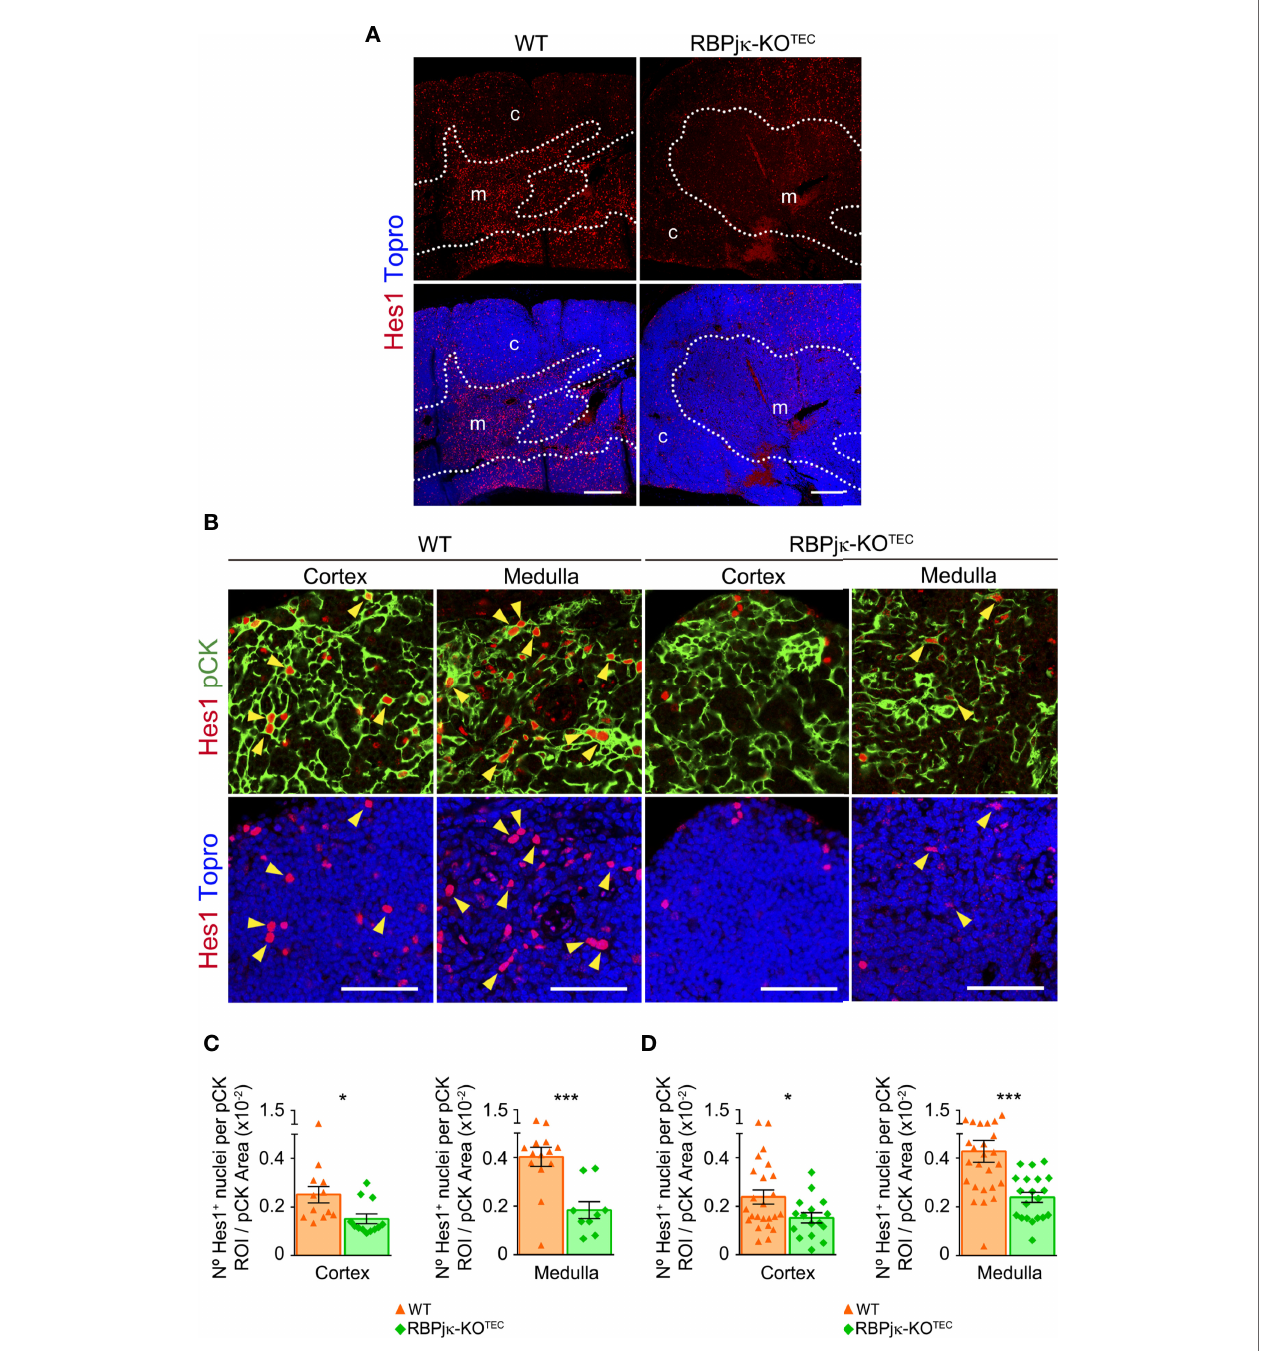
FIGURE 4 | Abrogation of canonical Notch signaling in postnatal TECs of RBPj k – KO TEC mice. (A) General view of Hes1 expression (red) in postnatal thymi (5- months) of mutant RBPj k – KO TEC and WT Foxn1 +/+ x RBPjk fl / fl littermate mice. Topro3 shows nuclear staining (blue). Scale bar: 200 m m. c, cortex; m, medulla. Dotted line, corticomedullary junction. (B) Immunohistochemistry of Hes1 (red), and pCK (green) with nuclei in blue (Topro3) in the cortex and medulla of postnatal thymi (5- months) from WT and RBPj k – KO TEC mice. Arrowheads indicate Hes1 nuclear expression. Scale bars: 50 m m. Images are representative of n ≥ 10 images per sample (n ≥ 3 independent thymus samples). (C, D) Bar graphs show numbers of Hes1 + nuclei within pCK + ROIs relative to total pCK + cellular areas analyzed in the thymus cortex and medulla of mutant RBPj k – KO TEC and WT Foxn1 +/+ x RBPjk fl / fl littermate mice aged 3-months (C) or 5-9-months (D) . Data are shown as mean numbers ± SEM per fi eld obtained from n ≥ 10 different 63x images per sample (n=4 independent samples). *p < 0.05; ***p <